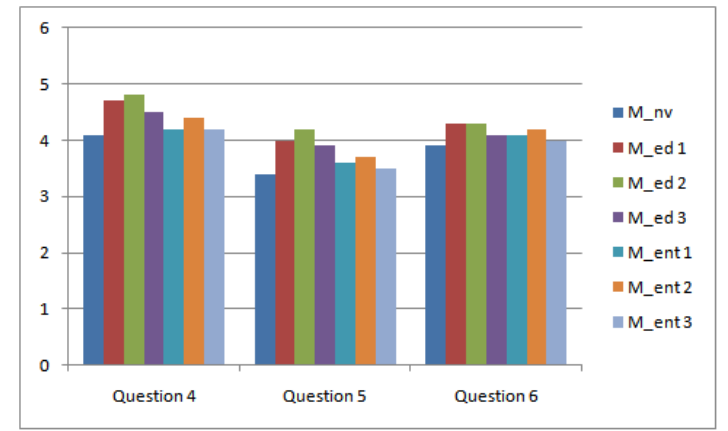
Figure 4. An illustration of MOS results for questions 4, 5 and